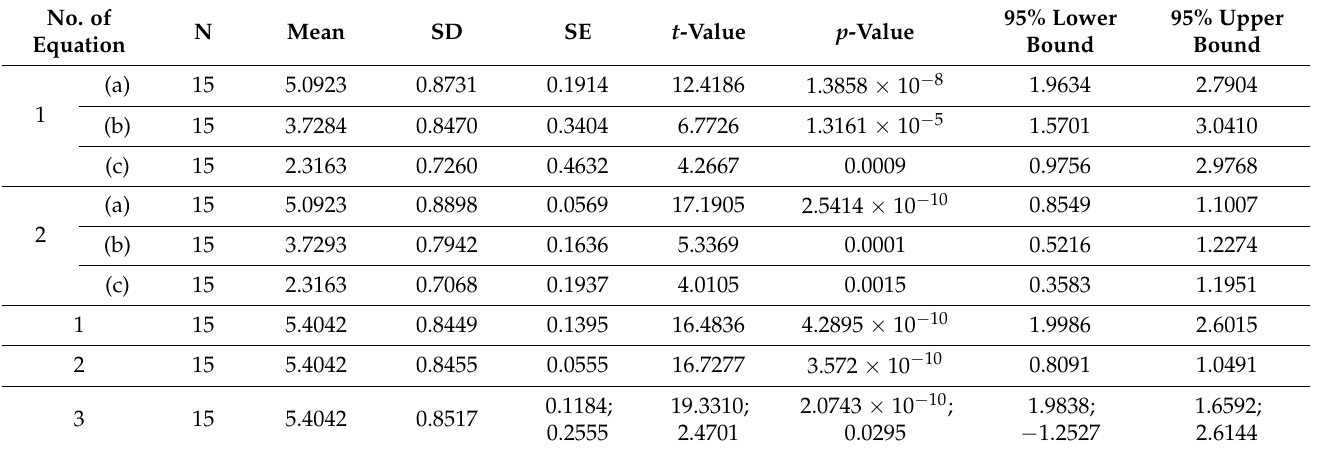
Table 3. Summary of the independent samples t-test of the allometric equation derived from 15 destructive samples using diameter at breast height, stem height, and wood density variables.